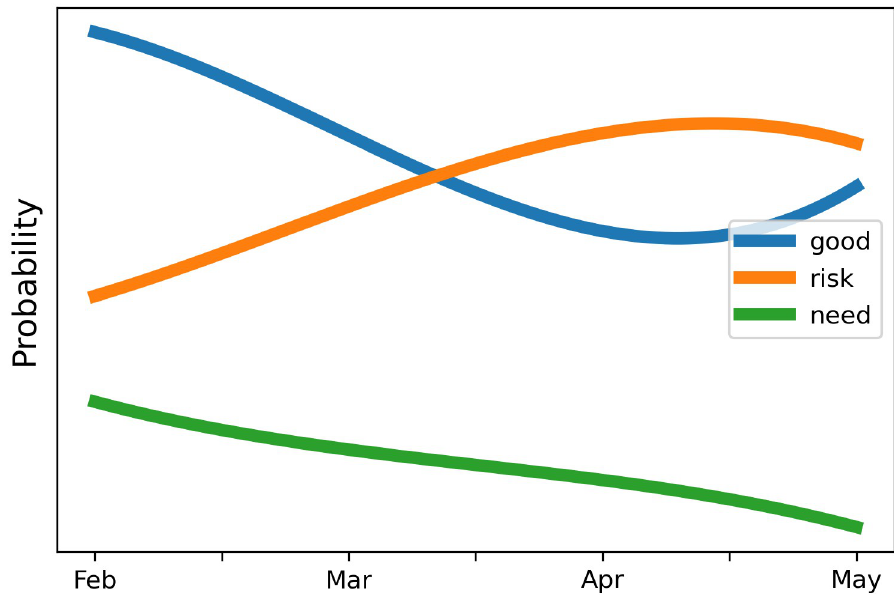
Fig 11. Dynamic topic model: Probabilities of some notable terms over the 4